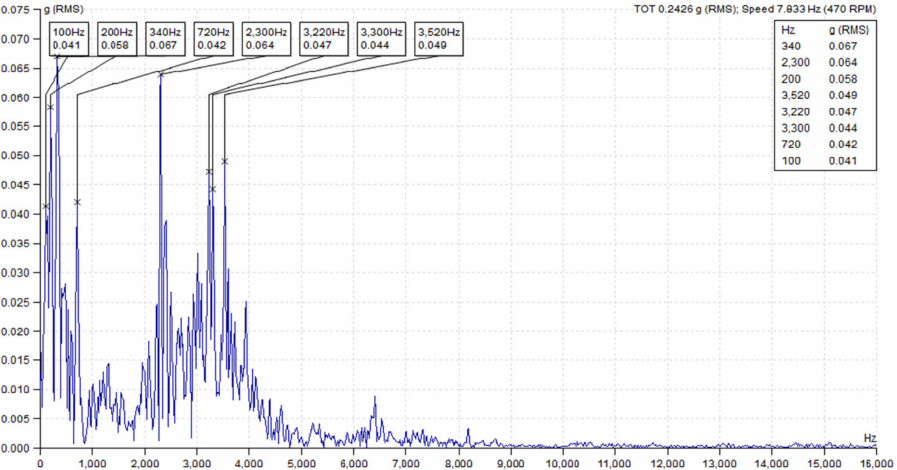
Figure 14. Top 8 peaks from the overall spectrum (10 Hz–16 kHz) of Massey Ferguson